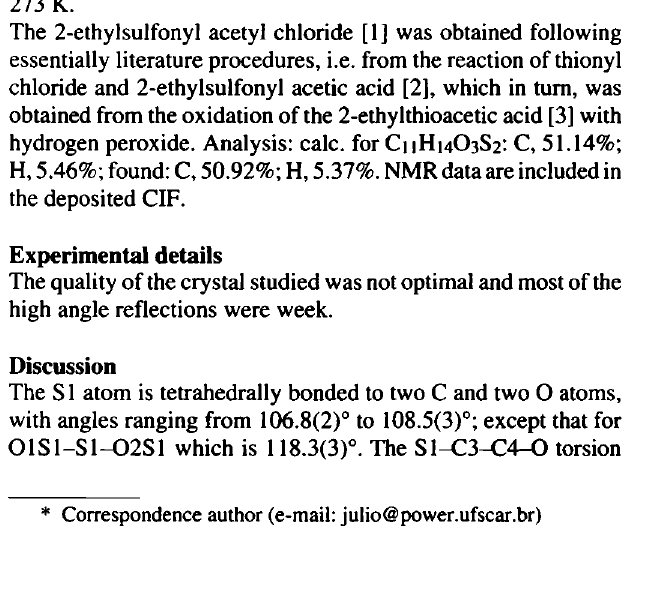
Table 2. Atomic coordinates and displacement parameters (in Ä 2